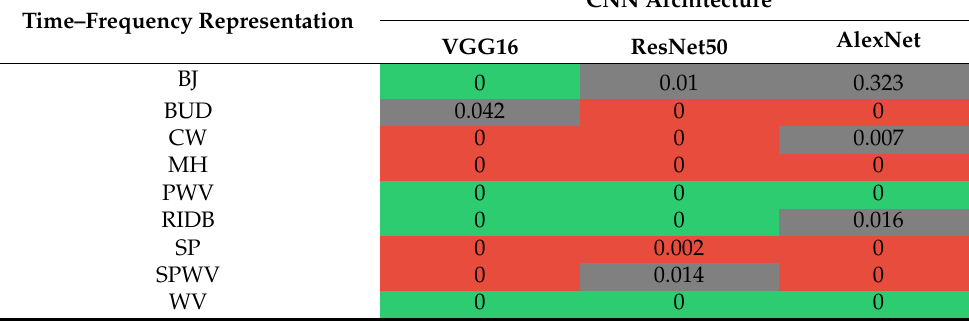
Table 5. p -values of the performed statistical tests ( α = 0.00¯3), using McNemar’s test. Each time– frequency representation is coupled with a convolutional neural network. The values are rounded to three decimal places. Statistically significant cases are marked in green and red. Green is used to indicate that a time–frequency representation model performed better than the base model, while red is used to emphasize the opposite. The cases where no statistically significant differences between the results of a time–frequency representation model and the base model were observed are marked in